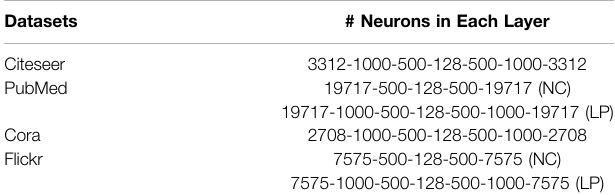
TABLE 3 | Detailed architecture information for datasets ( DANRL-CA-AM/ Infomap ).